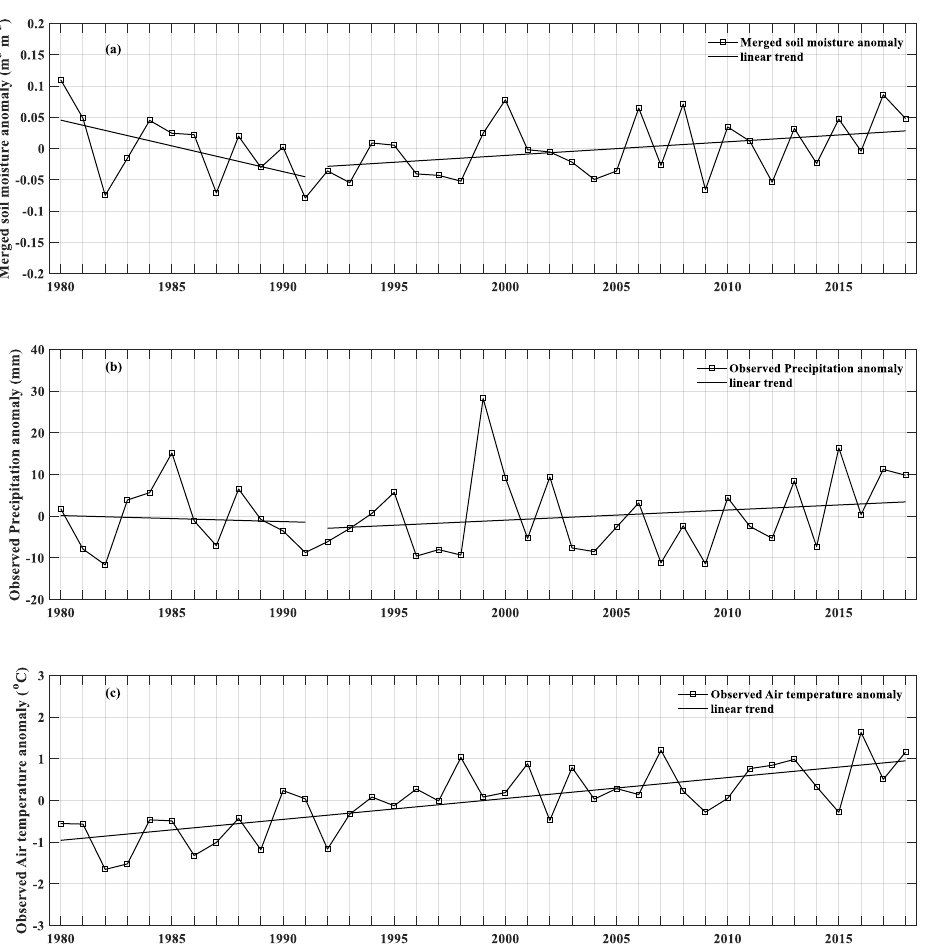
Figure 6. The temporal series of ( a ) the summer soil moisture ( S m ) anomaly of the merged dataset at the Ali site during 1980–2018; ( b ) same as in ( a ) but for the summer observed precipitation; ( c ) same as in ( a ) but for the summer observed air temperature.